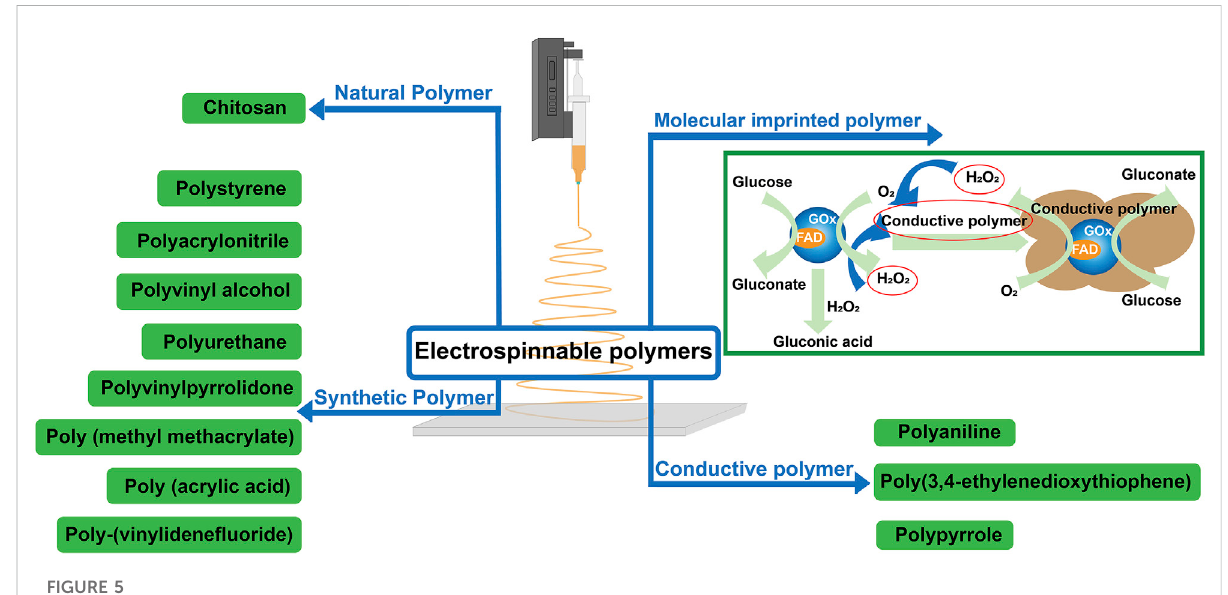
FIGURE 5 Types of polymers in electrospun glucose